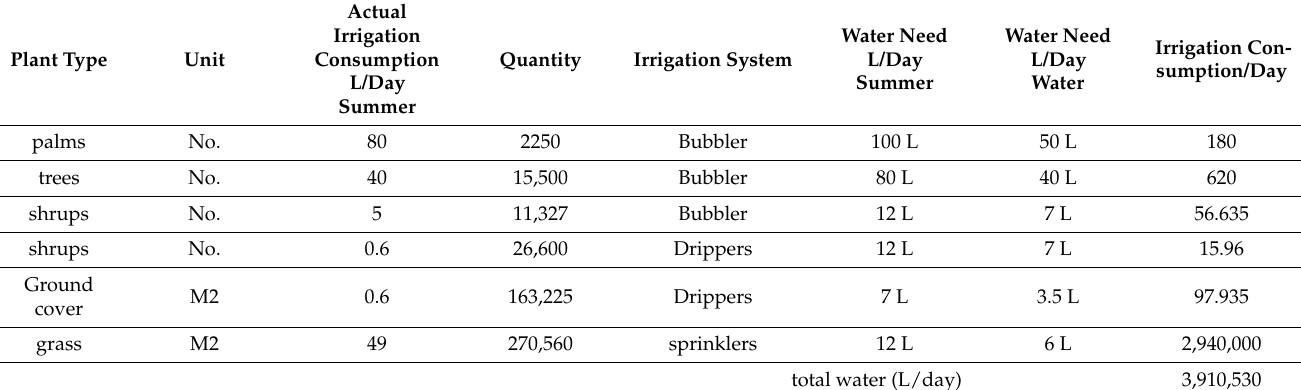
Table 3. Water requirement for the types and quantities of plants in the university